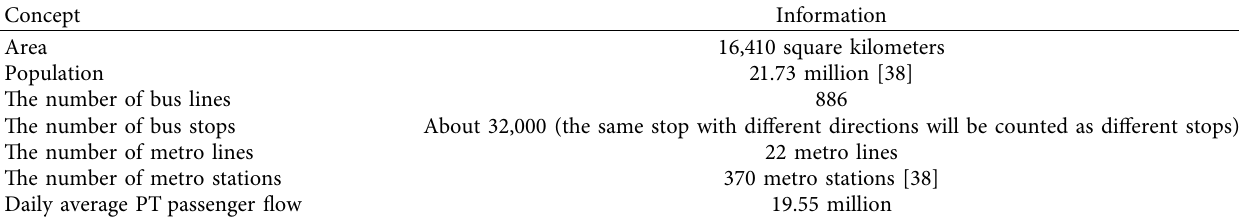
Table 1: Basic information of PT network in Beijing.